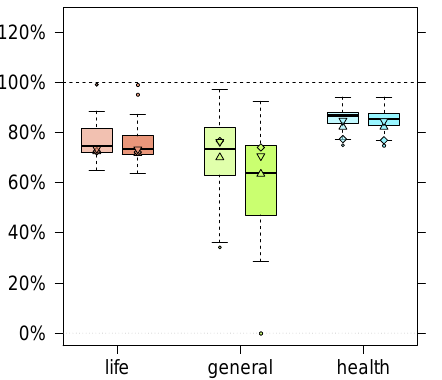
Figure 11. Impact ratios (cid:36) i caused by a fall of the equity market (left plots), see Figure 6, and combined with the cascading failure of reinsurers (right